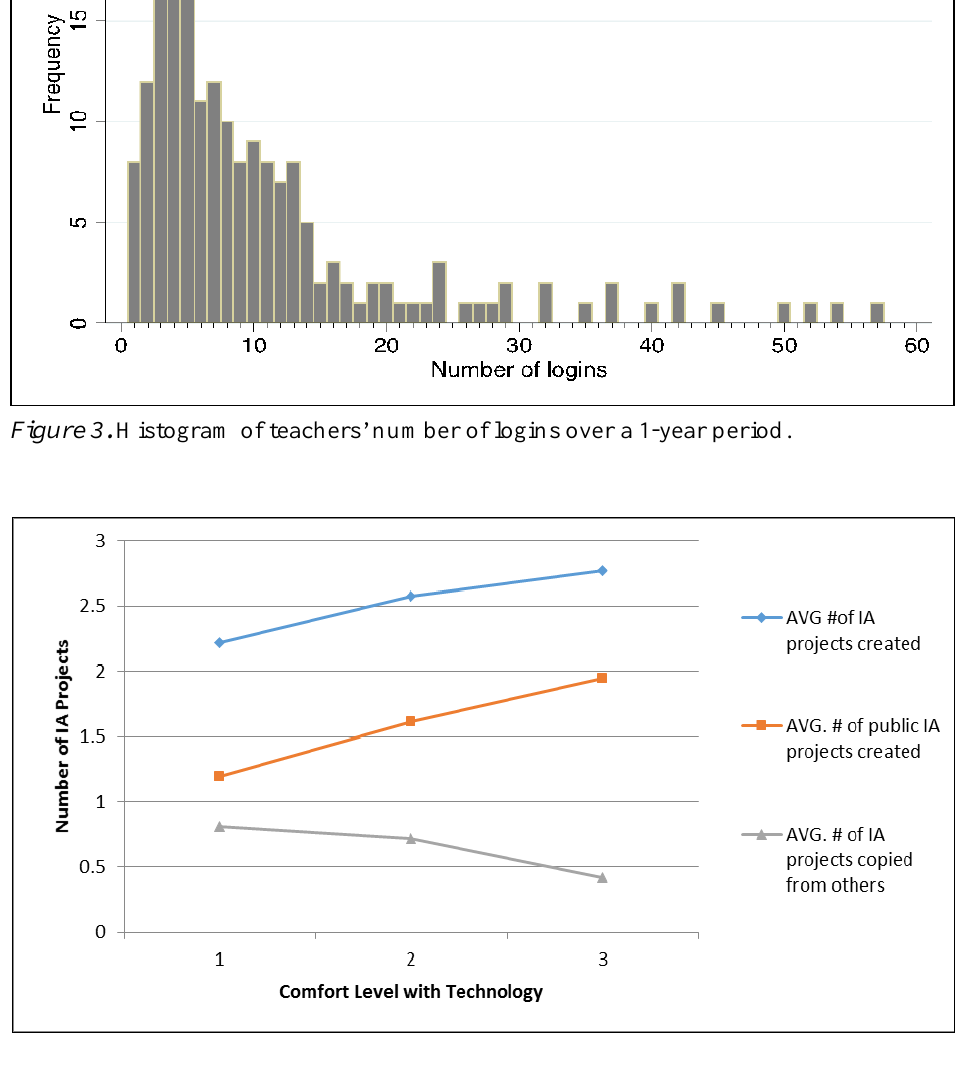
Figure 4 . Teachers’ creation activity categorized by their comfort level with technology. (For PD participants, comfort level with technology ranges from “0” to “4” levels; “0” refers to “novice” and “4” refers to “expert”. However, due to a change in the interface “in the wild” users reported their comfort levels on “1” to “3”